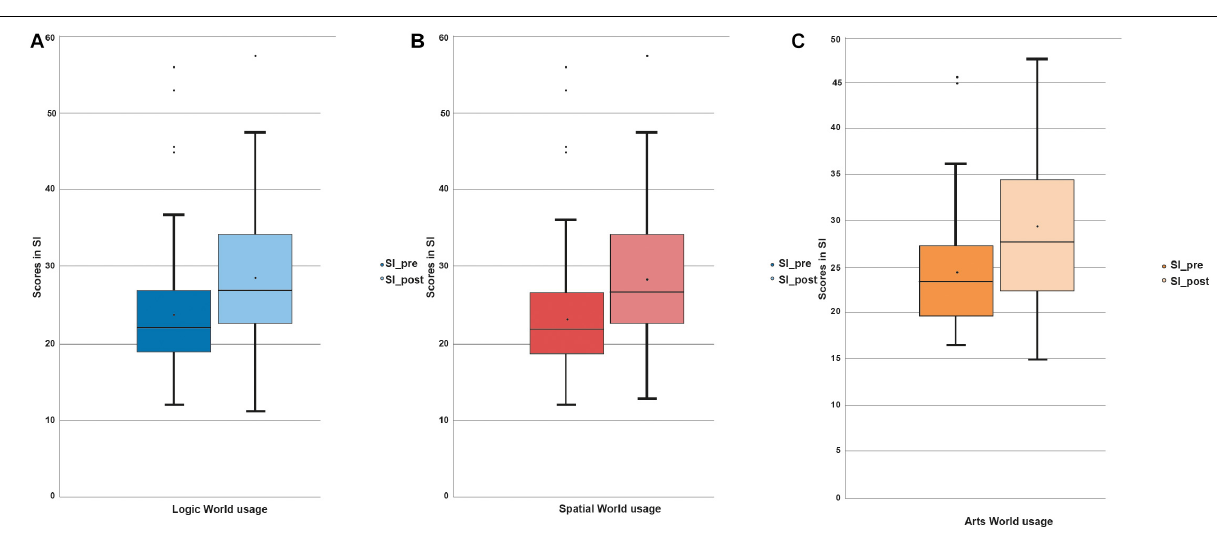
and the group with more use can operate as a pilot group. These groups were made for each world (i.e., Science, Logic, Spatial, and Arts). Statistics describing these groups are shown in Table 2